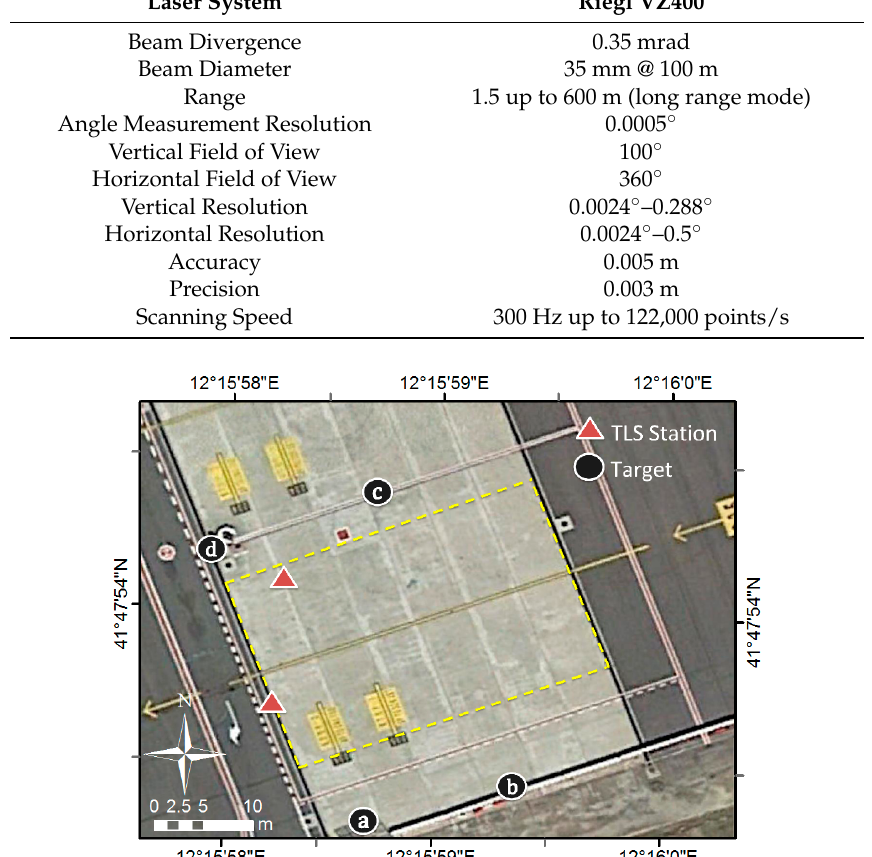
Figure 1. The case study apron (Google Earth image on 5 April 2015).